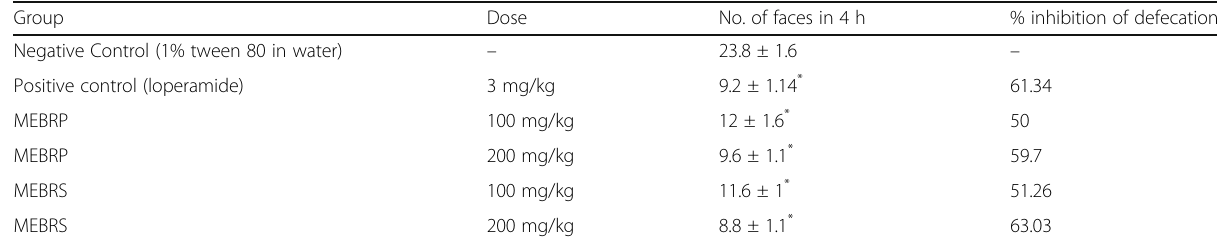
Table 5 Antidiarrheal effects of the methanol extract of the Baccaurea ramiflora pulp and seed on castor oil induced diarrhea in mice Group Dose No. of faces in 4 h % inhibition of defecation Negative Control (1% tween 80 in water) Positive control